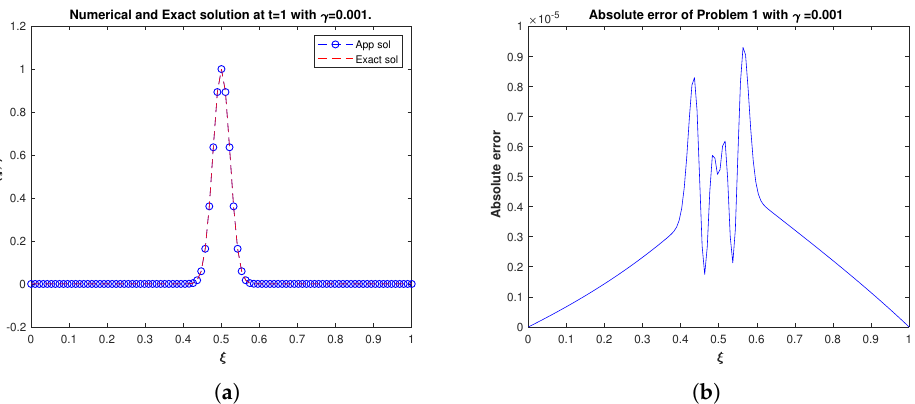
Figure 2. ( a ) The approximate and analytic solutions of Problem 1 with γ = 0.001, α = 0.8, N = 95, M = 24, and n = 10, at t = 1. We see that the problem has sharp Gaussian pulse when γ = 0.001. ( b ) Plot of absolute error of Problem 1 with γ = 0.001, α = 0.6, N = 150, M = 28, and n = 7, at t = 1.